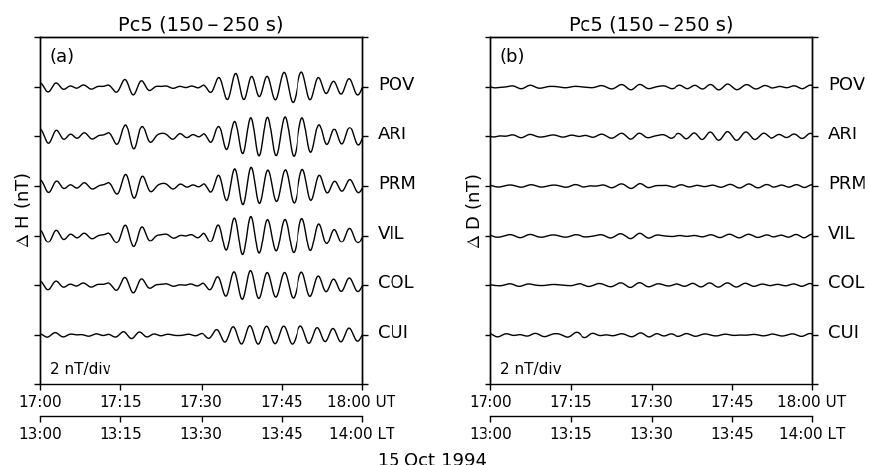
Figure 4. The same as Fig. 3, for Pc5 pulsations with periods ranging from 150 to 250s, in the afternoon on 15 October 1994. An event is observed in the H component after 13:30LT.